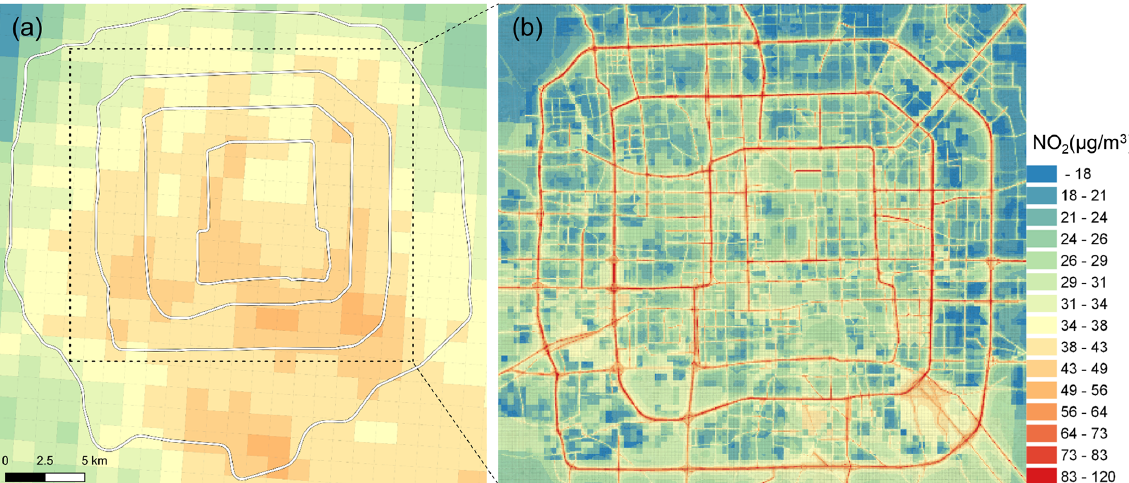
Figure 11. Spatial distribution of monthly averaged NO 2 concentrations from (a) the CMAQ model and (b) the CMAQ-RLINE_URBAN model. (© OpenStreetMap contributors 2020. Distributed under the Open Data Commons Open Database License (ODbL) v1.0.)